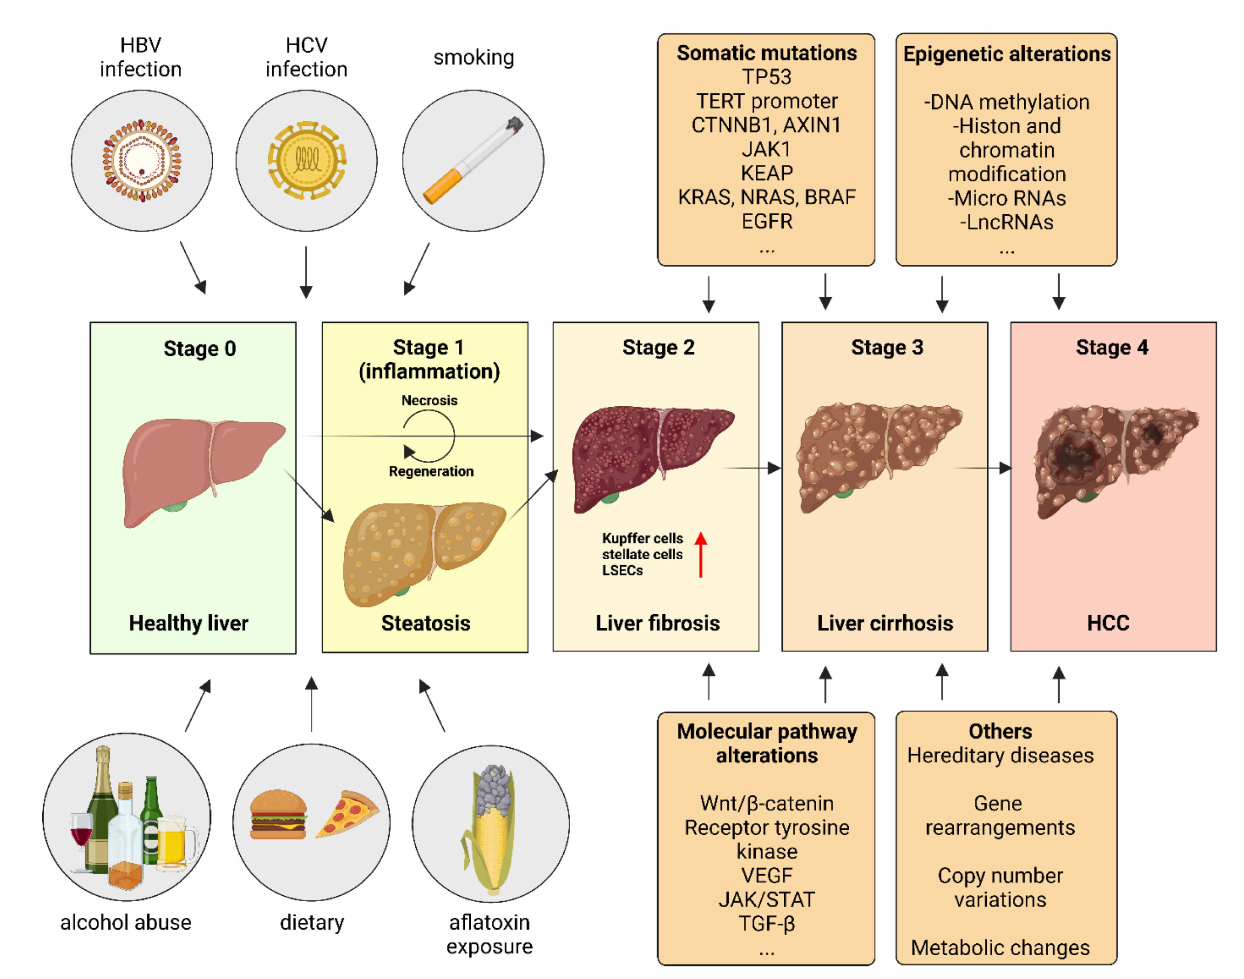
Figure 3. Etiology and risk factors promoting HCC carcinogenesis. Continuous chronic exposure to hepatic injuries caused by environmental factors (viral hepatitis, alcohol abuse, NASH, exposure to toxins, etc.) repeatedly damage the hepatocytes and induce inflammation eventually leading to liver cirrhosis. In this stage, the liver is susceptible to genomic instabilities. That is why it is more likely for the hepatocytes to accumulate somatic mutations, epigenetic changes, and gene rearrangements which can lead to metabolic changes and molecular pathway alterations. These dysregulations drive tumor progression and